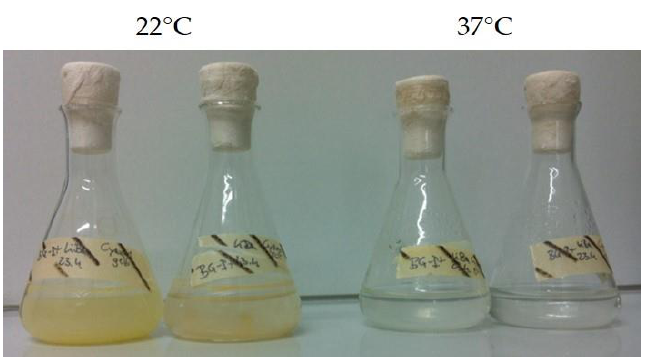
Figure 8. Growth of isolated cyanobacterial accompanying flora inoculated in BG-I medium at room temperature (22 °C) and elevated temperature (37 °C).